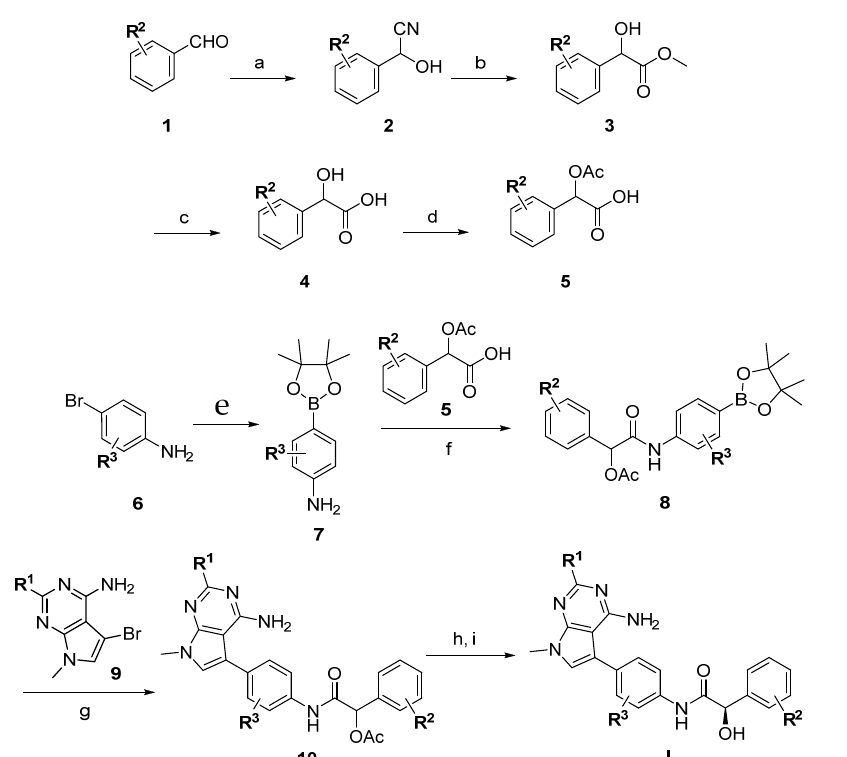
Scheme 1. General synthesis of PERK inhibitors. Reaction conditions: ( a ) TMS-CN (1.2 equiv.), Znl